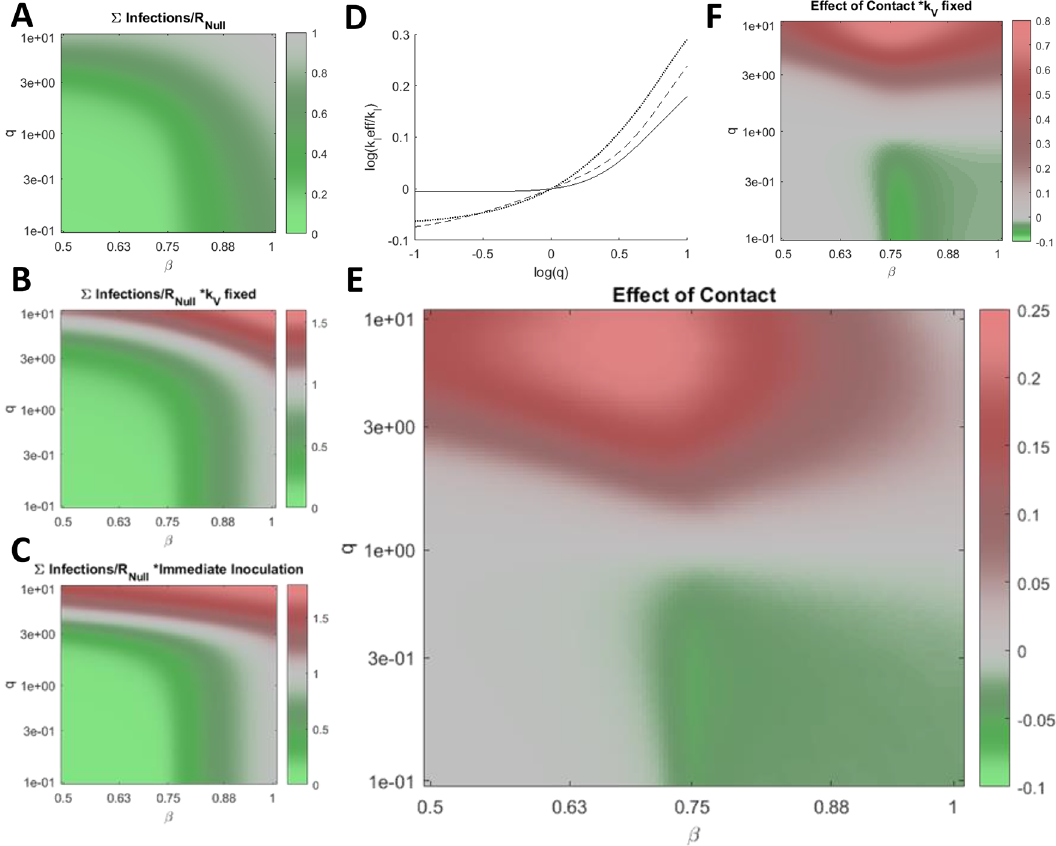
Figure 3. Post-vaccination contacts. A. The cumulative number of infections relative to no vaccination, R Null , for a range of β and q , where k V = MCI minimizes the cumulative number of infections for each condition. B. Same as in A. for fixed k V = 0.03 representing the inoculation of 3% of na ï ve hosts per day. C. Same as in A. for the case where all na ï vehostsareimmediatelyinoculated.D.Logoftheeffective k I , k I eff, relativeto k I =0.2,thebenchmark, versus logof q for b = [0.5 (dotted line), 0.7 (dashed line), 1 (solid line)]. E. The cumulative number of infections relative to R Null and q = 1 scaled by the fraction of infections due to vaccine escape, ∑ Escape( q )/ ∑ Infections( q )( ∑ Infections( q )- ∑ Infec- tions ( q = 1))/ R Null , for a range of β and q , where k V = MCI for each condition. F. Same as in E for fixed k V = 0.03. A-C/E/F. 961 values were computed for each panel and 4 (cid:3) by 4 (cid:3) bilinearly interpolated points are